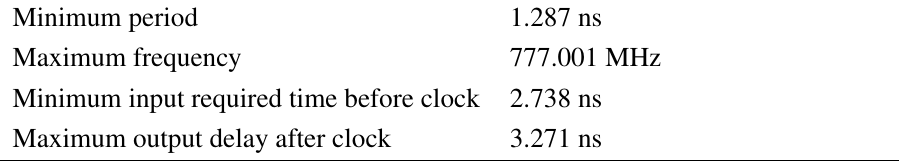
Table 1. Temporal results for the AC module.